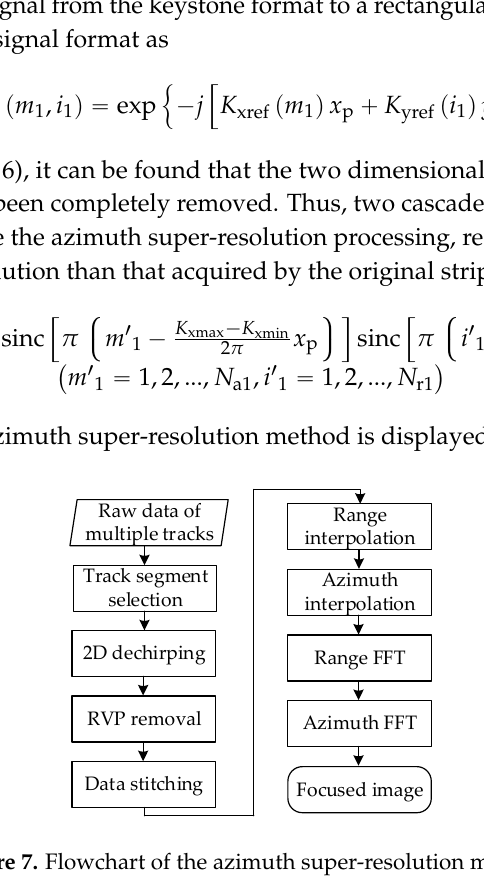
( c ) Figure 8. Wavenumber spectrums with ( a ) too much overlapping; ( b ) gaps; and ( c ) too narrow range wavenumber bandwidth. Secondly, the look angle  , affected simultaneously by the slant ranges and the track altitudes, determines the distribution of the range wavenumber K y as shown in Equation (10). If  of selected tracks differ too much from each other, the range wavenumber bandwidth between K ymin and K ymax